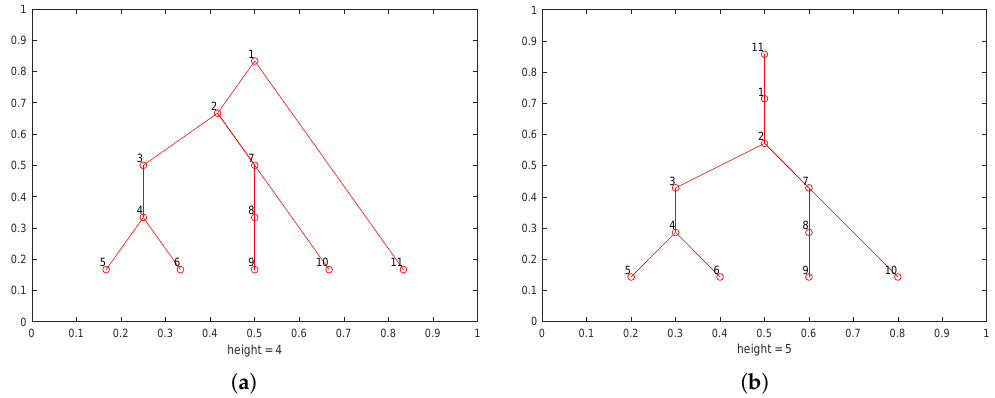
Figure 15. The result of root changing method. ( a ) The relationship between nodes before changing. The node 1 is the root node of this sub-tree. ( b ) The tree after changing. The root node changes to node